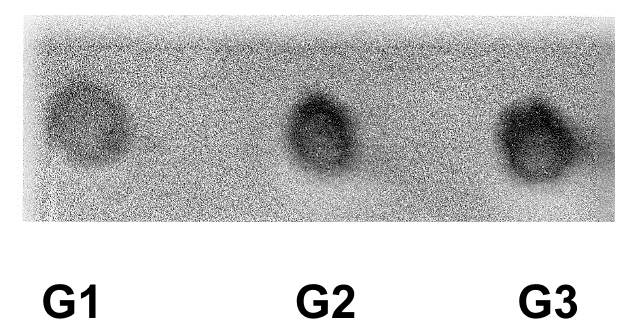
G1 G2 G3 FIGURE 1 - Scanned image of a polyvinylidene difluoride (PVDF) membranes recording the immunoblotting of carbonyl proteins presented in intestinal plasma samples in the three experimental groups. Group 1: Control; Group 2: Sham laparotomy; Group 3: Ischemia/reperfusion (I/R). The darkening of blots is correlated to the enhancement in carbonyl protein level in intestinal plasma samples